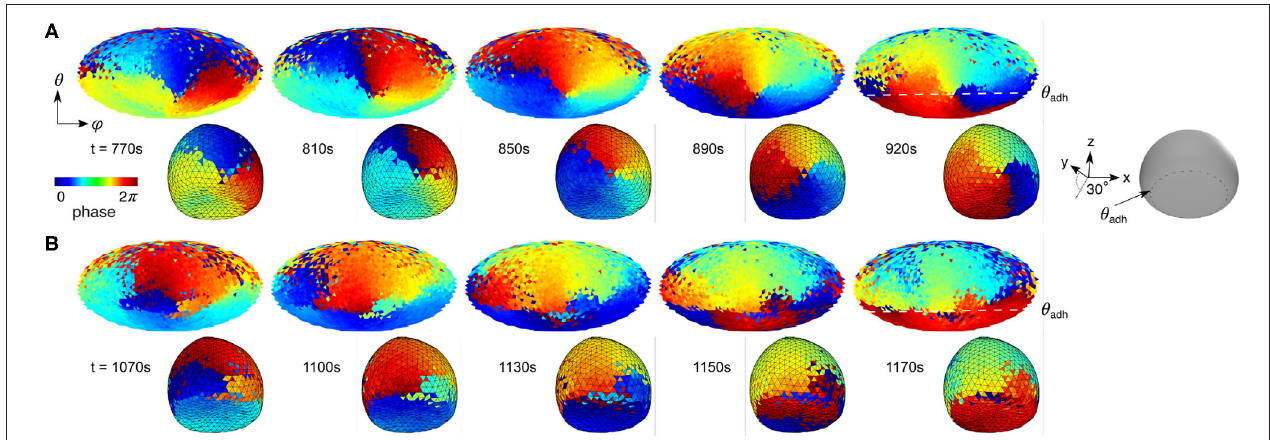
FIGURE 6 | Contact perimeter guides PIP3 waves. (A) Contact perimeter serves as pinning site. (B) Contact perimeter guides PIP3 waves. Snapshots of phase maps are shown in 2D (top) and 3D (bottom). 3D maps are tilted 30 ◦ for showing the ventral membrane too, as shown by the gray 3D illustration where θ adh is illustrated. The cell that is used to show this patterns is shown in Figures 3B,D , and its relation between contact angle (cid:127) and speed ratio v a marked by a red circle in Figure 5A